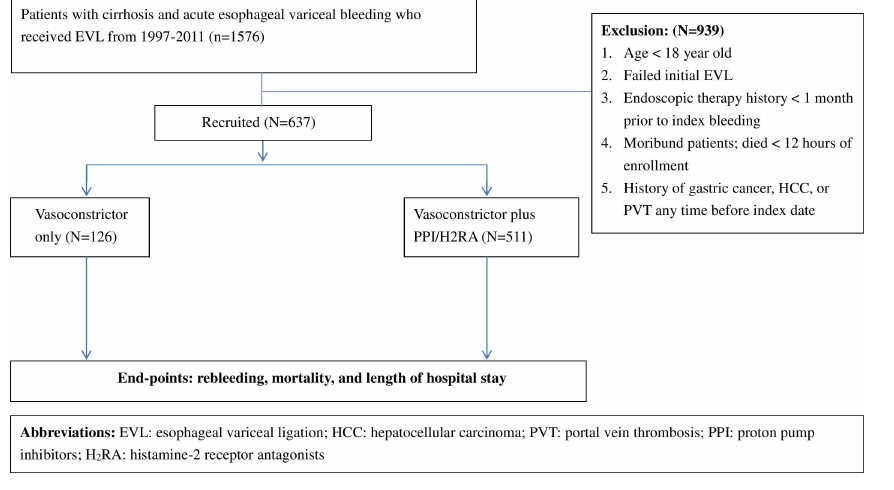
Fig 1. Schematic flowchart of the study